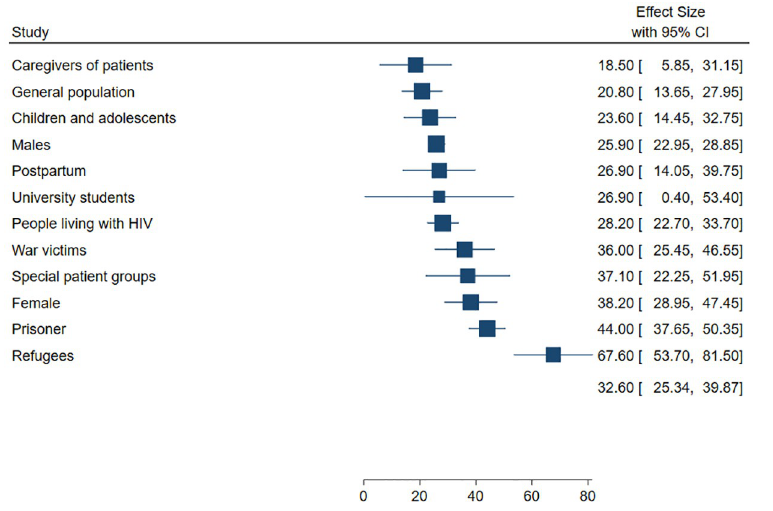
Fig 4. Prevalence of depression in different study groups in Uganda.